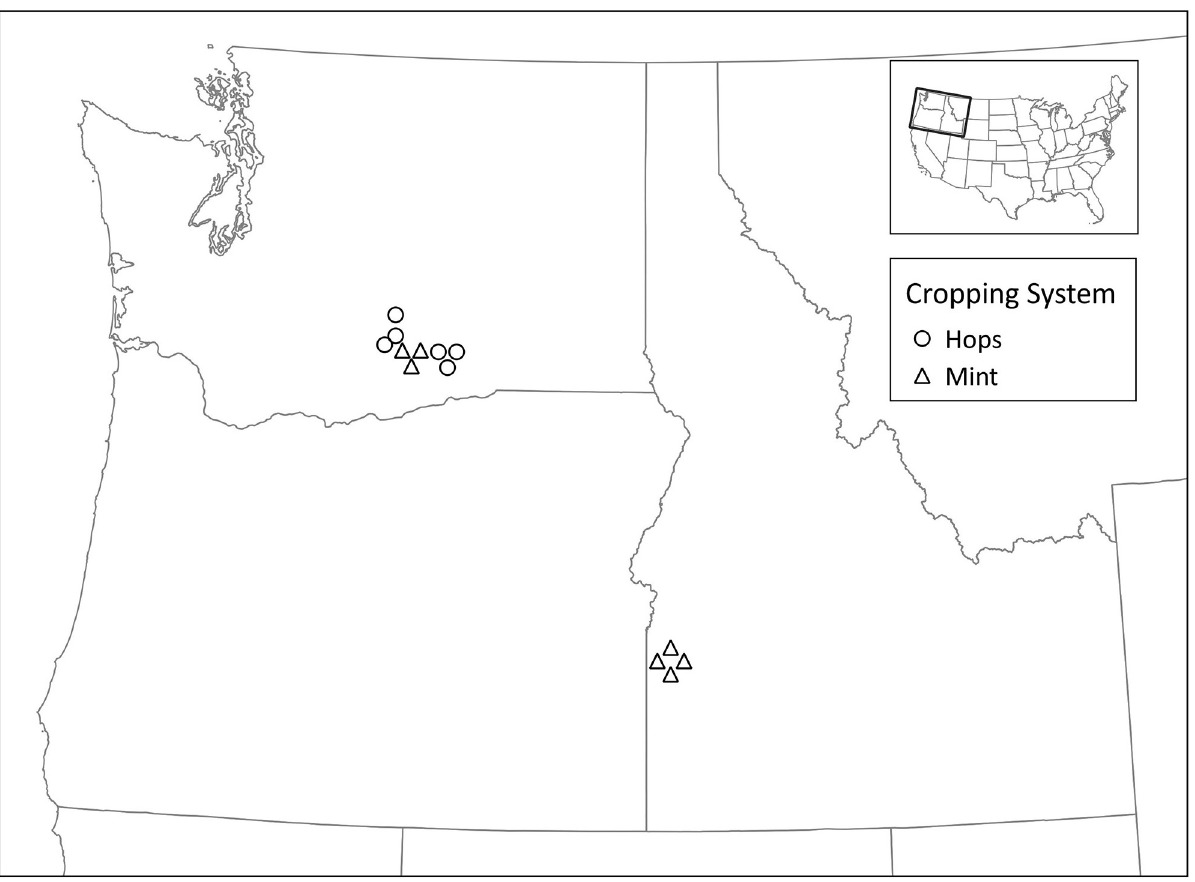
Fig 1. Field collection sites for T . urticae from mint fields and hop yards in the Pacific Northwest of the United States.